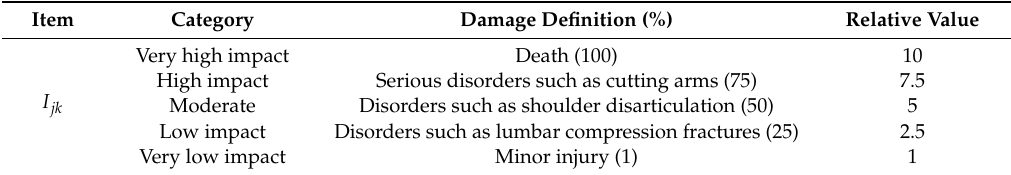
Table 9. Job risk damage definition and relative values.